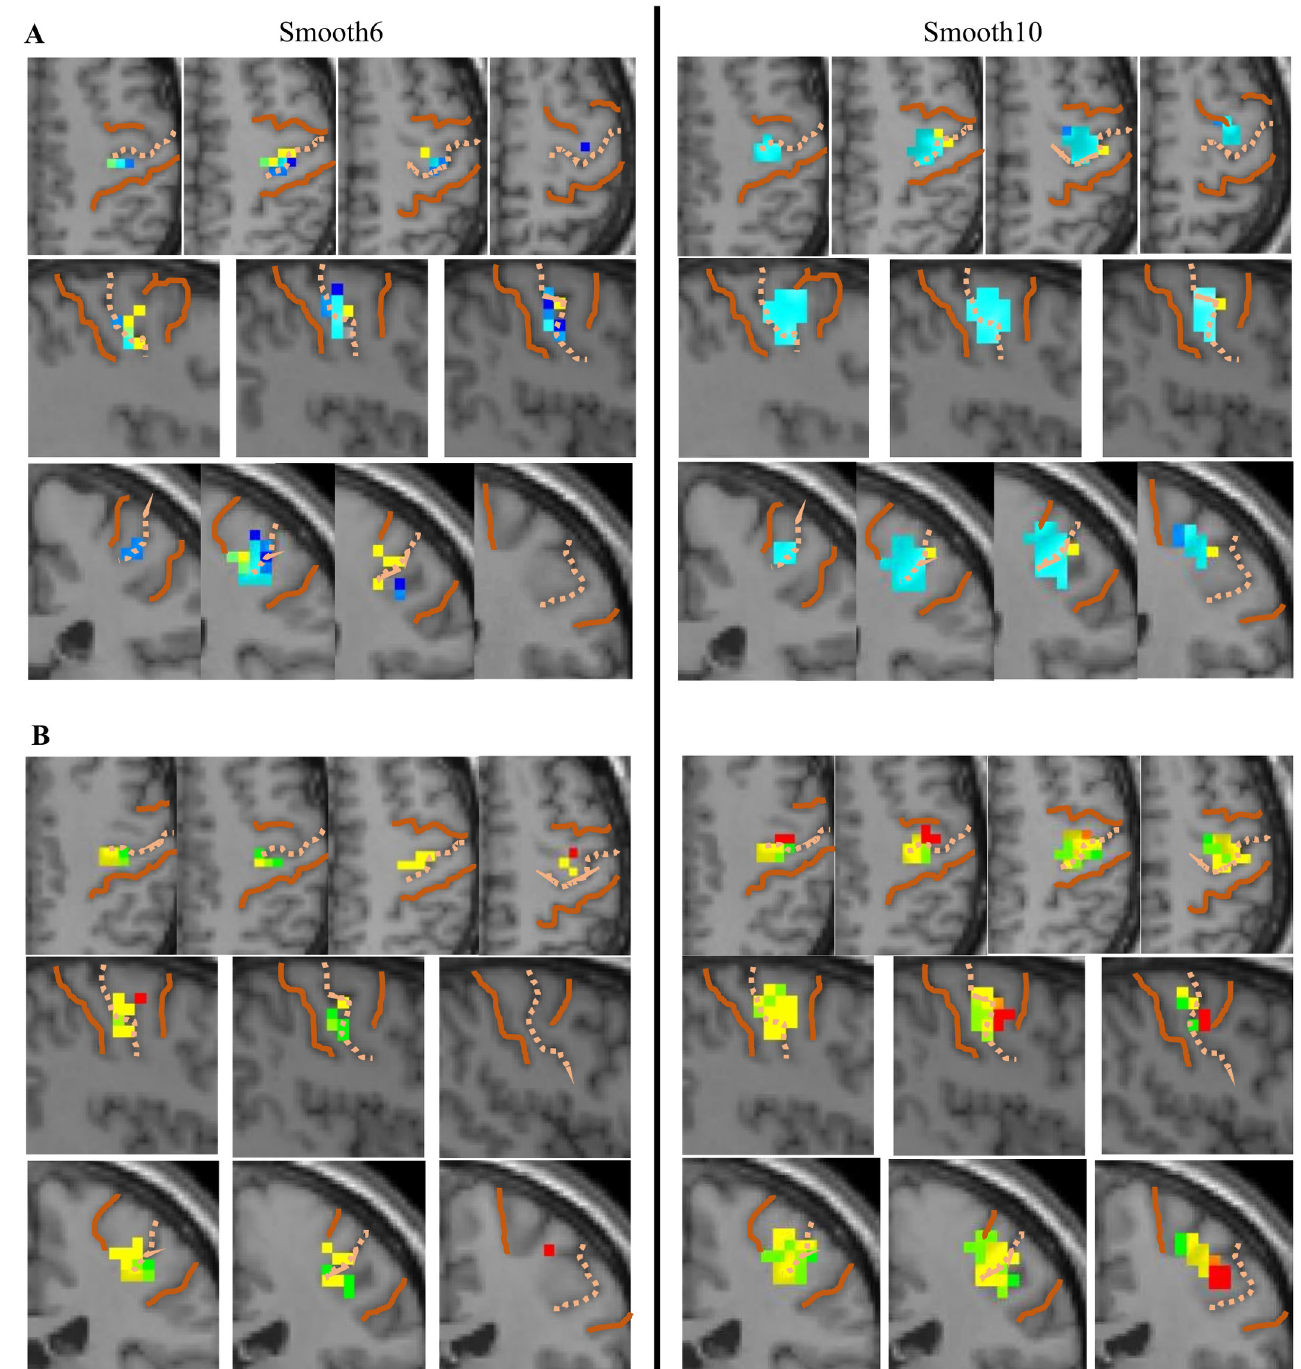
Fig 6. Effects of smoothing kernels on hippocampal connectivity from structural seeds during repetitive tapping. (A) Connectivity plotted from structural seeds along the medial/lateral axis of the hippocampus near its center, specifically, B1 (yellow, central-medial), B2 (cyan, central-middle), and B3 (dark blue, central-lateral). A larger area of connectivity was apparent with 10mm smoothing; a topographical organization was suggested with both smoothing kernels, although partly obscured with 10mm smoothing due to the enlarged area of connectivity from B2 (cyan). (B) Connectivity plotted from medial structural seeds along the longitudinal axis of the hippocampus, specifically, seeds A1 (red, anterior-medial), B1 (yellow, central-medial), and C1 (green, posterior-medial). The 10mm smoothing kernel generated a larger area of connectivity and a distinct topographical organization within each plane. Images illustrate random effects analysis of bilateral connectivity from 4mm isovoxels; SMC boundaries are demarcated with solid orange lines, with dotted lines demarcating the central sulcus.